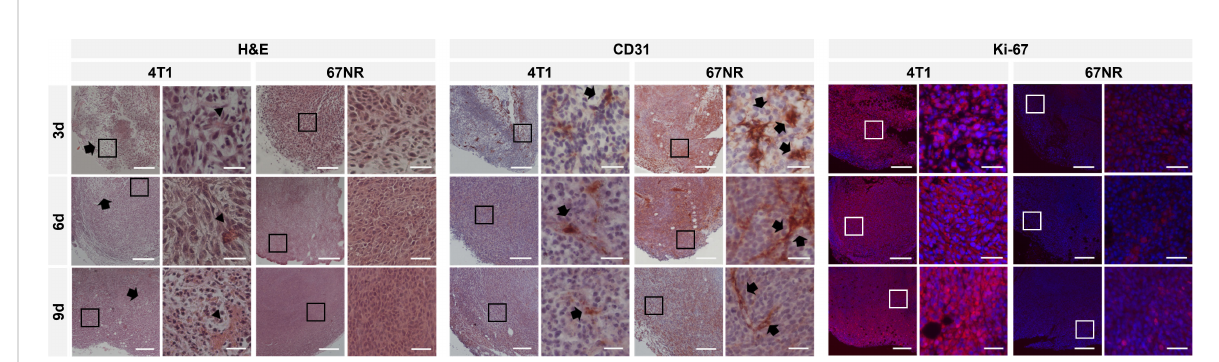
FIGURE 7 Histological and immunohistochemical analysis of tumor slices at 4x and 20x magni fi cation. H&E staining showed heterogeneous 4T1 tumors with increasing intratumoral bleeding over time (arrowheads) and areas of necrosis (arrows), while 67NR were more homogenous and showed only little intratumoral hemorrhage. CD31 staining showed more CD31 positive cells (arrows) in 67NR tumors, which were also more organized. Fluorescence staining for Ki67 revealed a higher expression in 4T1 tumors than 67NR tumors on days three, six and nine (stained in red, DAPI in blue), re fl ecting the highly malignant phenotype. In 4T1 tumors, the expression seemed to increase, while in 67NR tumors, the expression slightly decreased. Scale bars represent 200 m m (4x magni fi cation) and 50 m m (20x magni fi cation). Boxes in the 4x magni fi cation images represent the area of the 20x magni fi cation